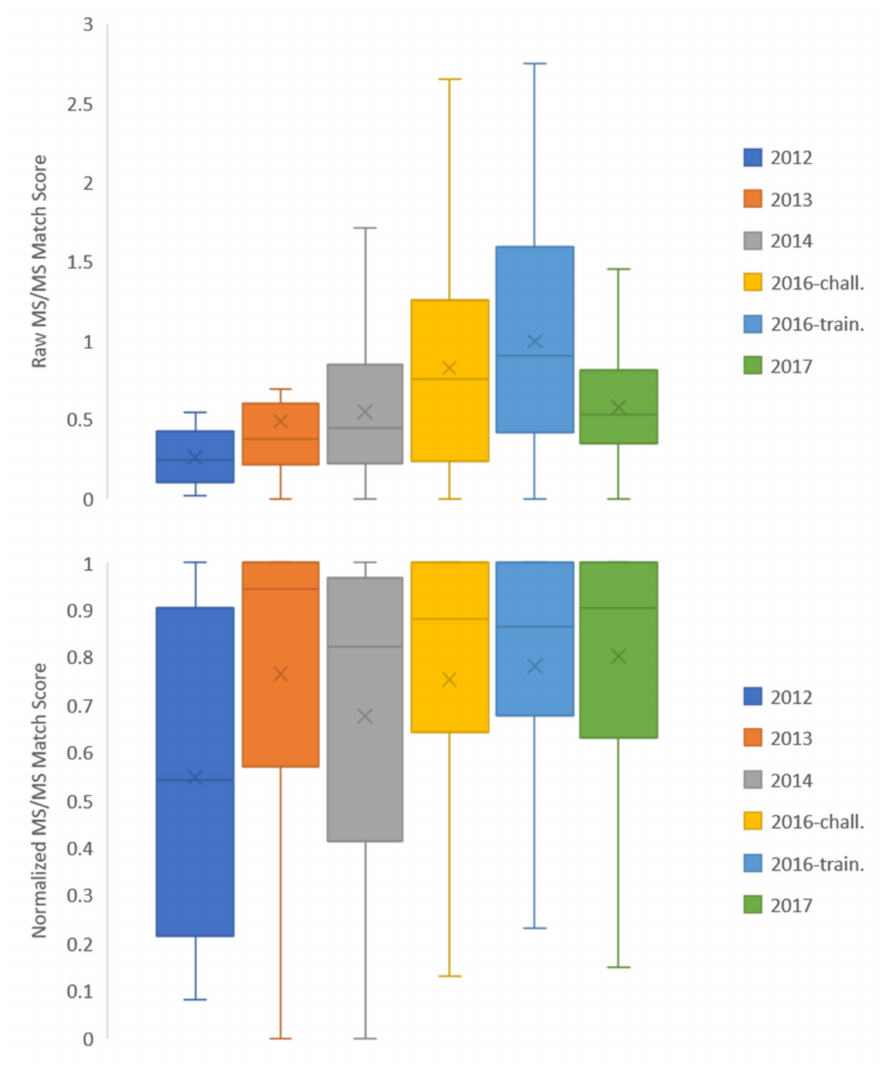
Figure 4. (Top) Raw MS / MS match scores from all compounds in each CASMI year dataset and (Bottom) match scores normalized to the highest score within each candidate set by contest year (the “quotient” term as defined by Chao et al.). Raw scores range from 0 to 3.0 and normalized scores range from 0 to 1.0. Within each contest year, box edges define the 25th and 75th percentile of scores, while the interior line defines the median. “x” markings indicate the